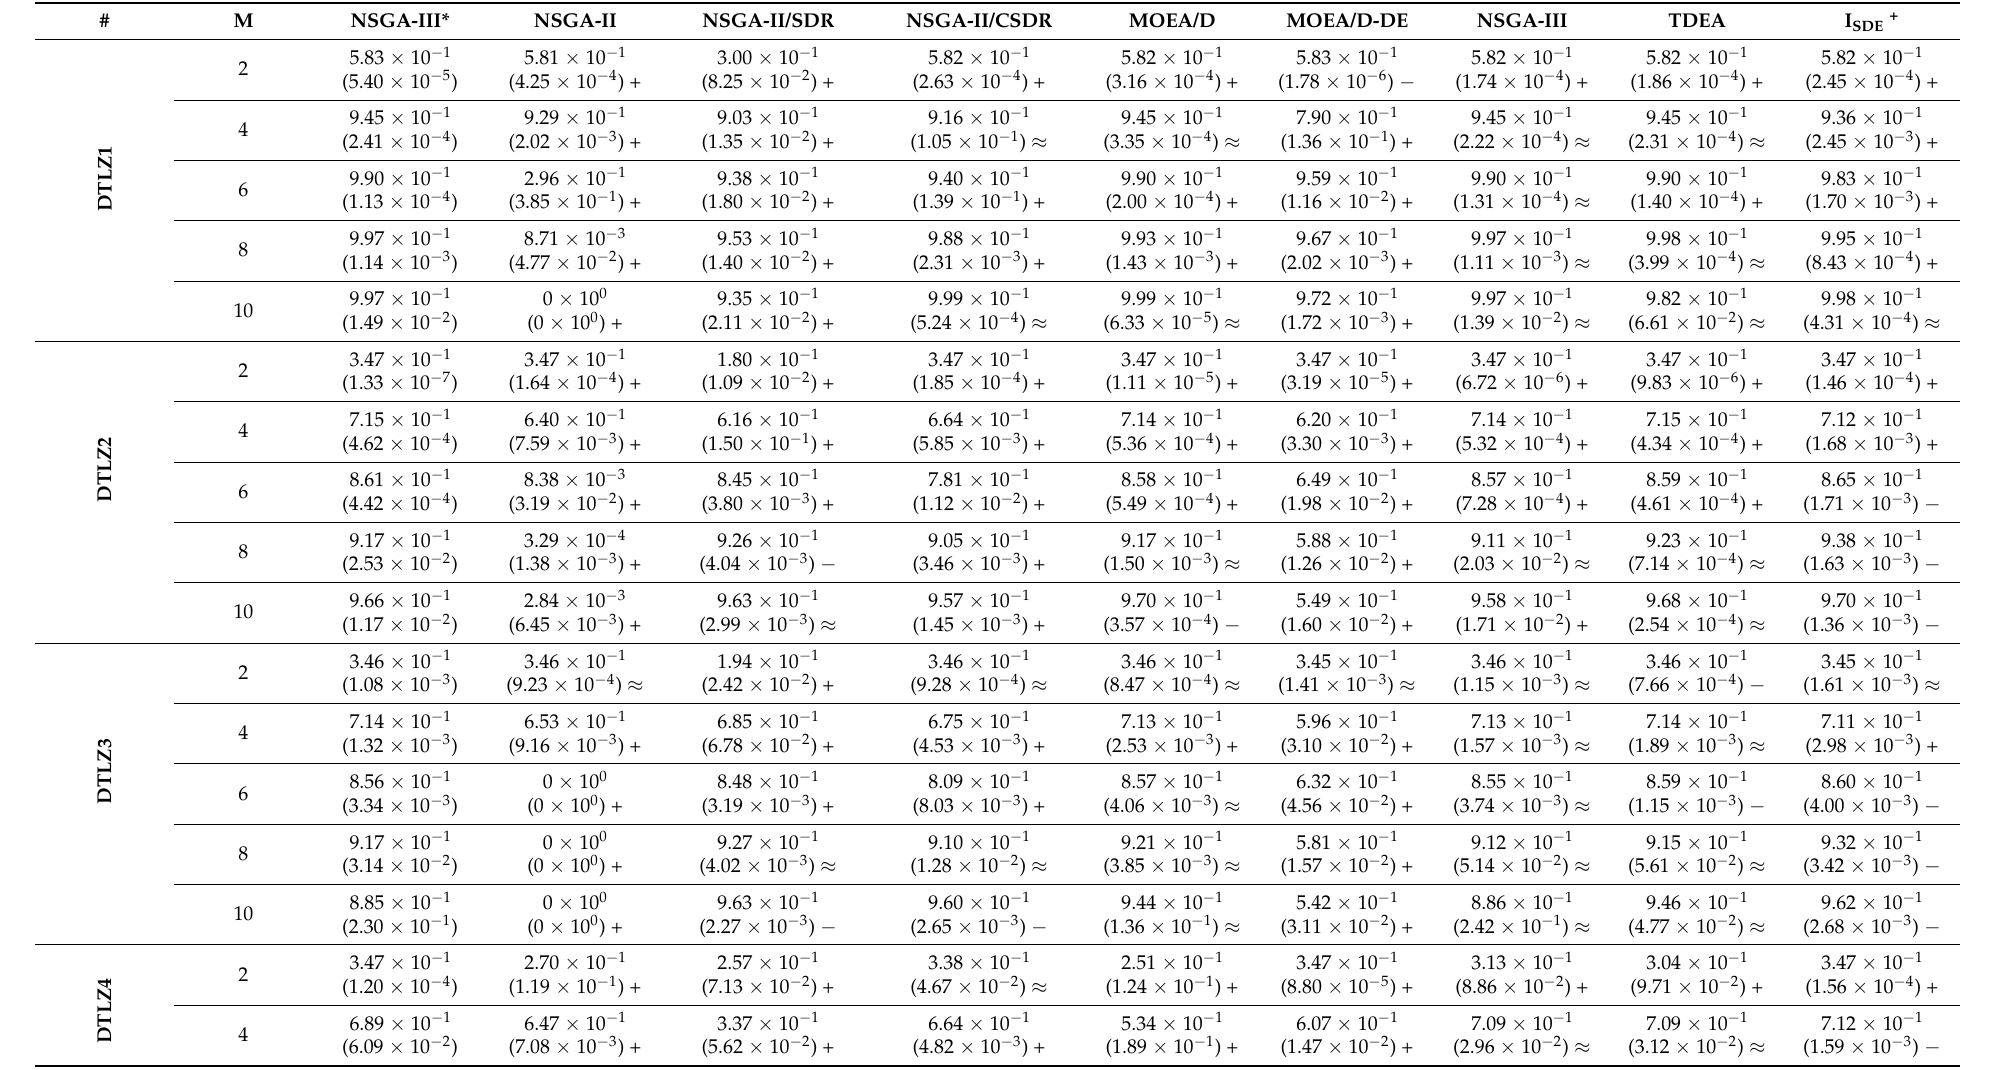
Table 2. Comparison of HV and statistical results on DTLZ and WFG test problems (“+”–WIN, “ ≈ ”–TIE, “ −